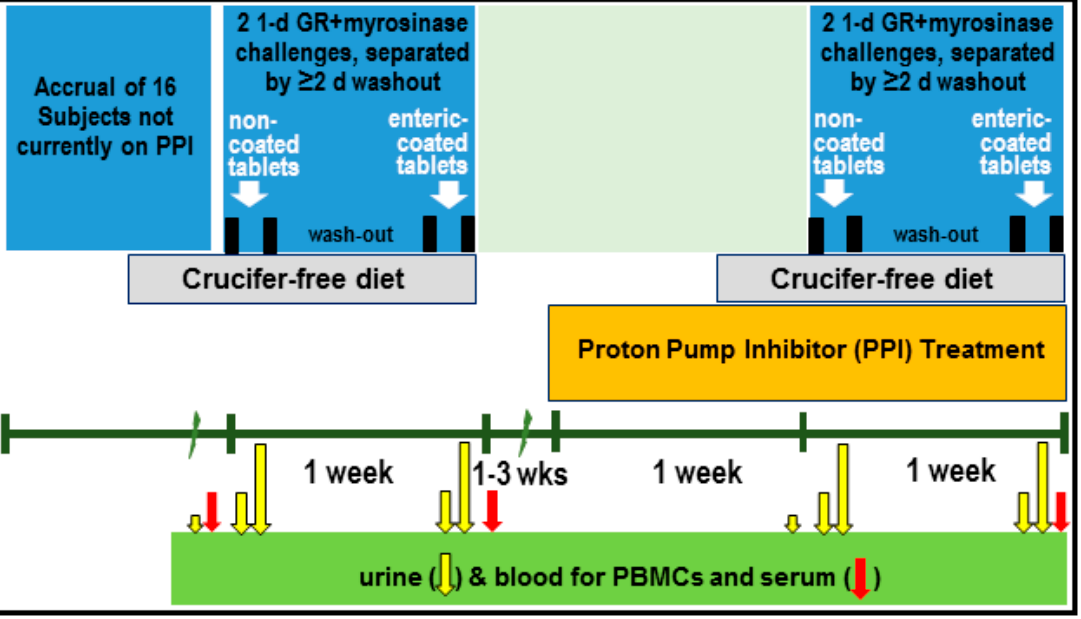
Figure 1. Design of PPI Phase clinical intervention.